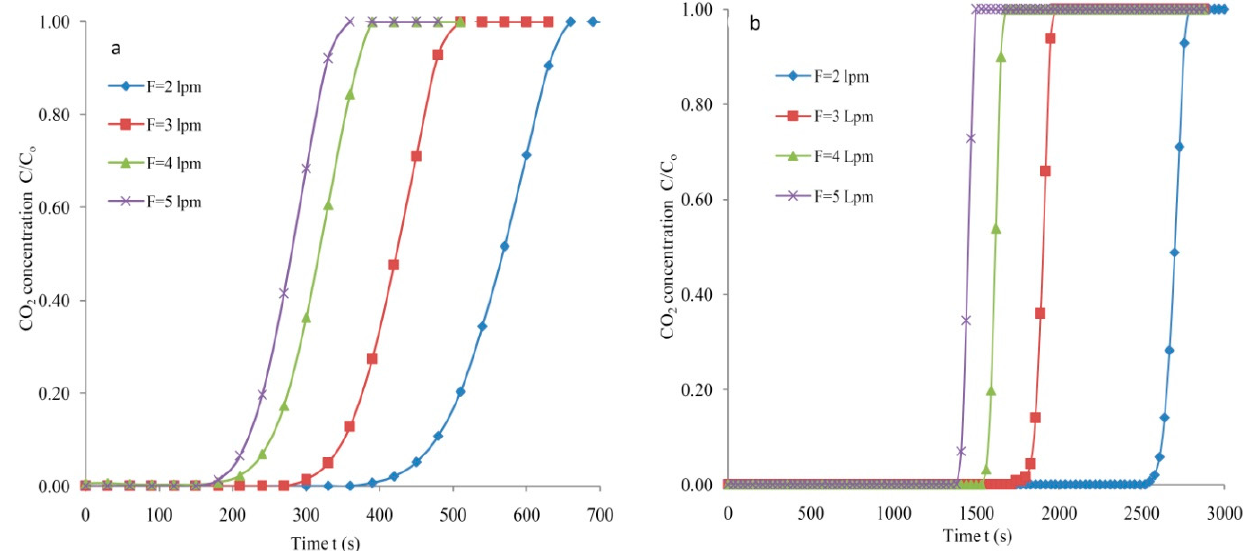
Figure 9. Dependence of adsorption responses on feed flow at T = 298 K, C o = 5% ( a ) SG and ( b ) AC.